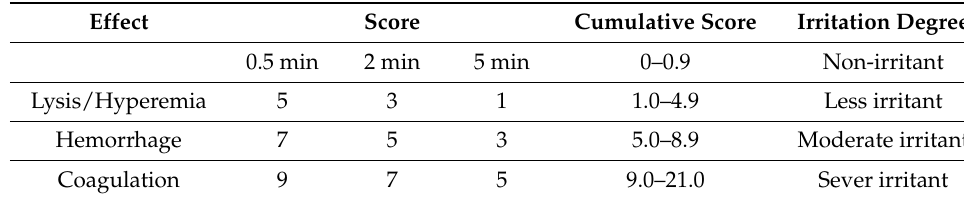
Table 2. Scoring scale for the HET-CAM